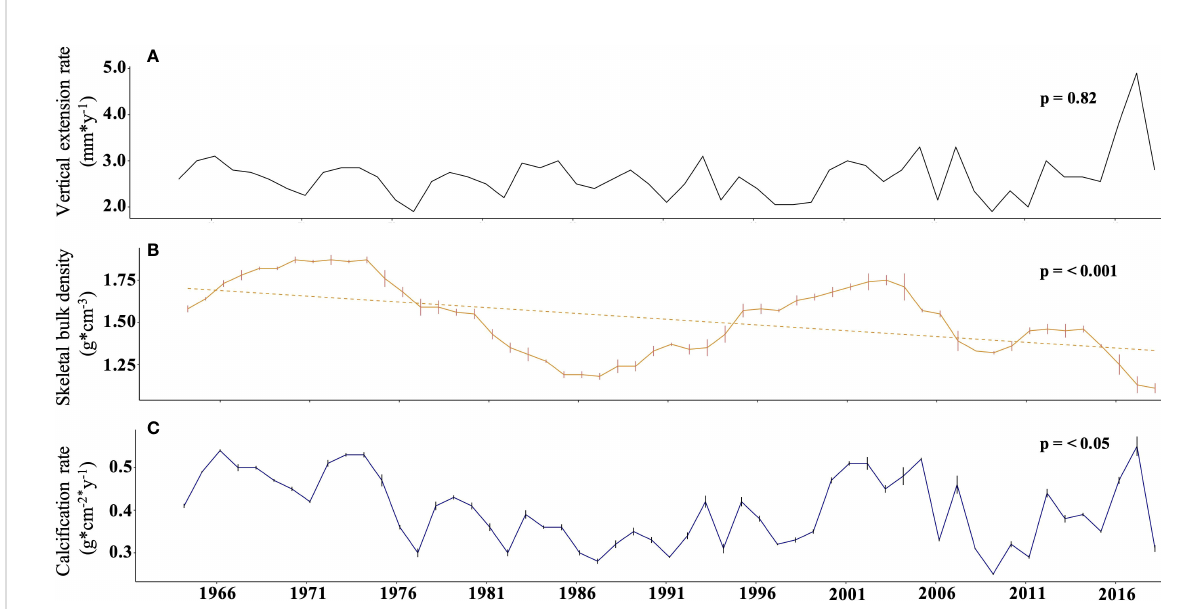
FIGURE 5 Evolution of the different coral growth parameters of the studied Diploastrea colony over the last 54 years. (A) . Annual linear vertical extension rate (mm). (B) Annual bulk density of the coral skeleton (g*cm -3 ). (C) . Calculated annual coral calci fi cation rate (g*cm -2 *y -1